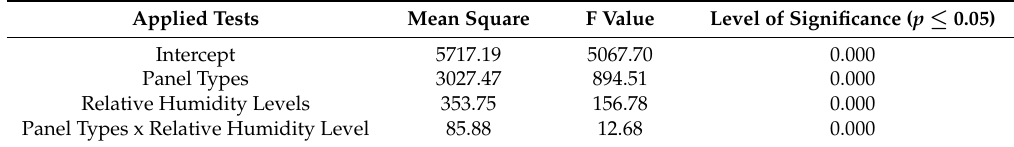
Table 3. ANOVA results related to the effect of average surface roughness Ra level. based on the humidity levels and wooden composite